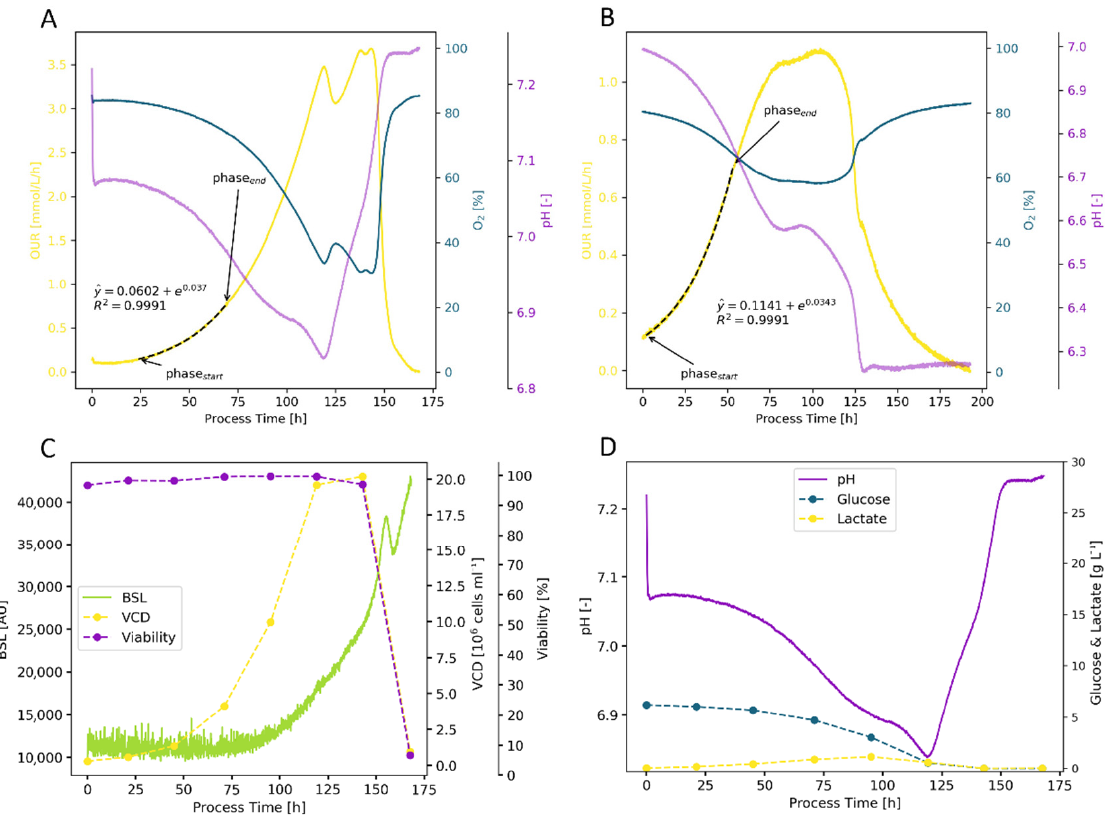
Figure 6. Cultivation of ExpiCHO-S 6H8 ( A , C , D ) and CHP DP12 #1934 ( B ) cells in unbaffled 250 mL Erlenmeyer flasks with 80 mL working volume, 120 rpm shaking rate and 50 mm shaking amplitude. Growth rate determination was performed with the OUR signal (yellow line), resulting in µ OUR, auto. = 0.037 h − 1 for ExpiCHO-S ( A ), and µ OUR, auto. = 0.0343 h − 1 for CHO DP-12 ( B ). For low cell densities, the BSL signal had a high signal to noise ratio, which decreased as cell density ( C ) increased. The BSL signal increased as viability decreased, indicating a measurement of the dead cell density ( C ). The production and consumption of lactate was visible in the pH signal (purple line), with the lactate shift at 120 h clearly visible ( D ).